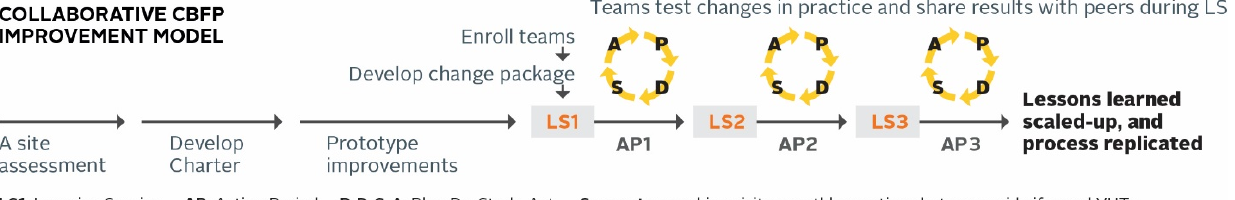
Figure 2. Collaborative Improvement